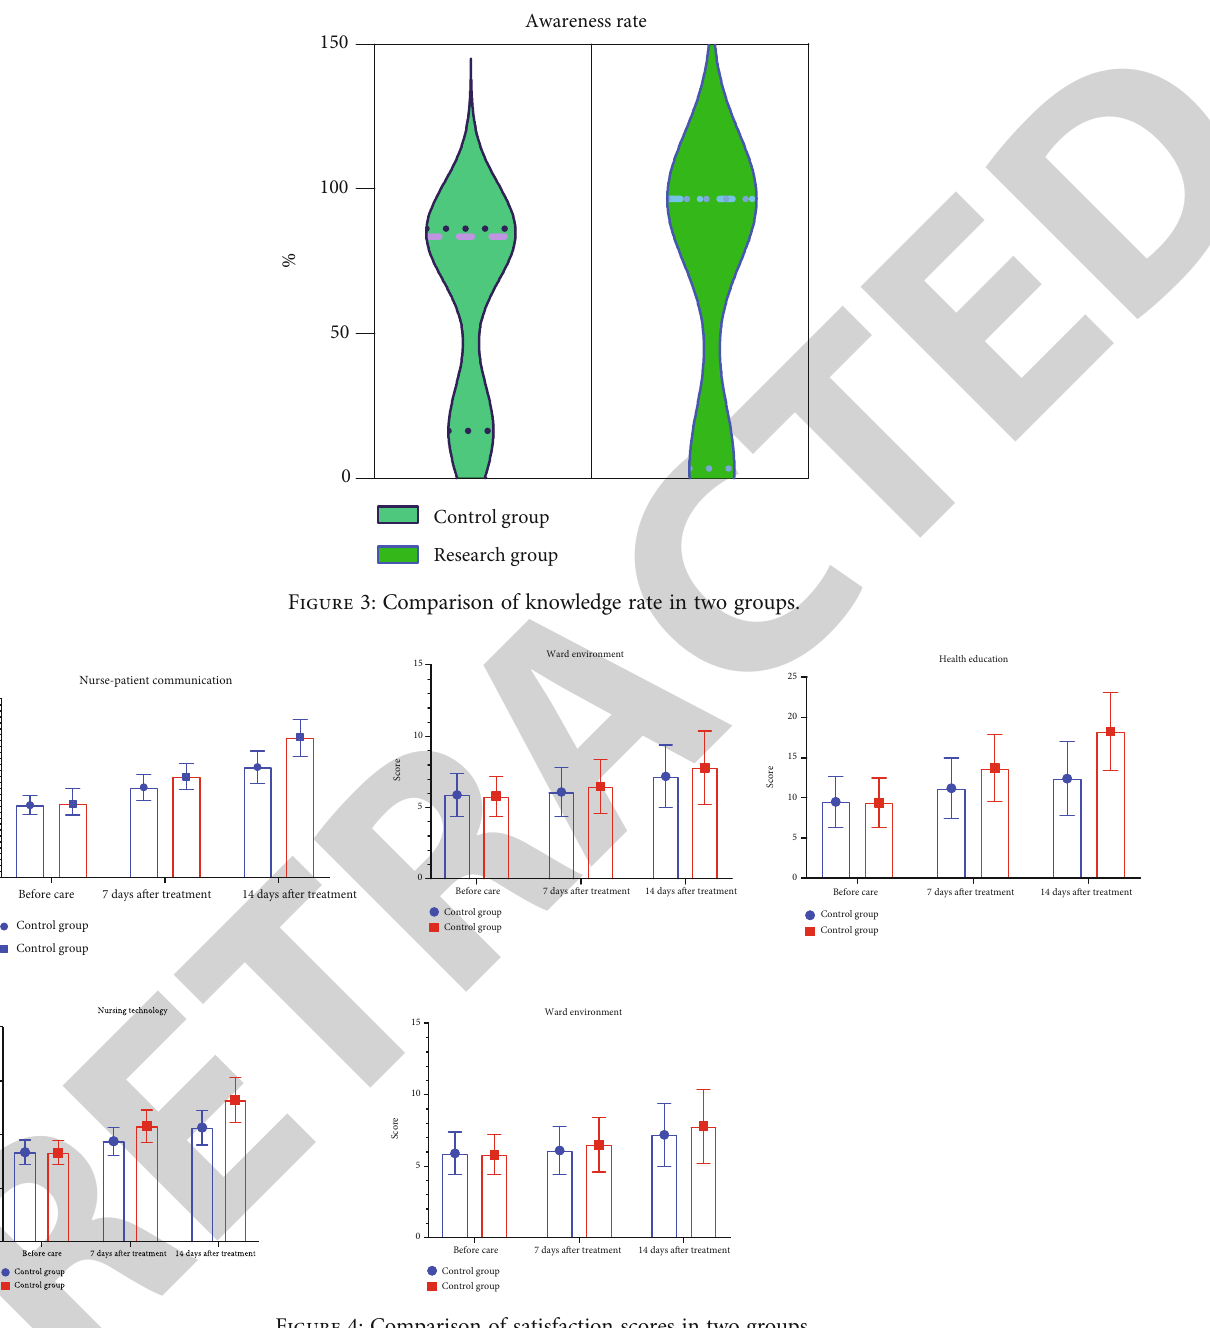
Figure 4: Comparison of satisfaction scores in two groups.